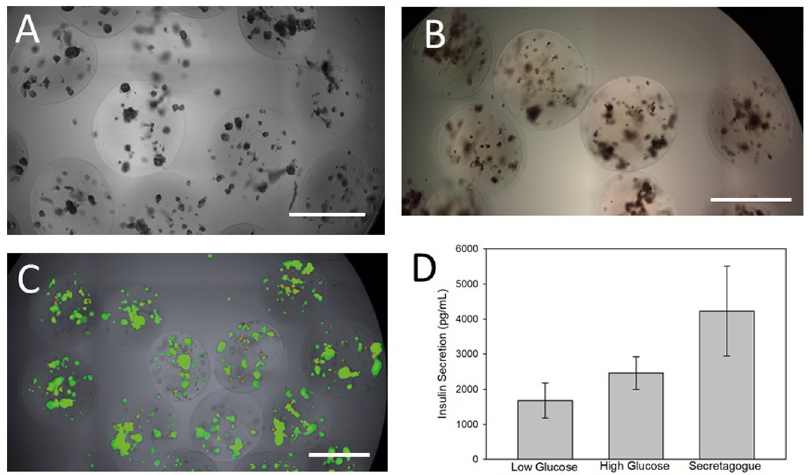
Fig 2. Characterization of microencapsulated canine islets. A) Typical field of microspheres containing canine islets. B) Dithizone staining of the encapsulated cells indicated the insulin-positive islets contained within the microspheres. C) Viability was determined with calcein and PI showing a typical example. Scale bars = 1 mm for all images. D) Static incubation insulin release was measured from encapsulated islets in low (2.8 mM), high (16.7 mM) and high glucose with 30mM K +